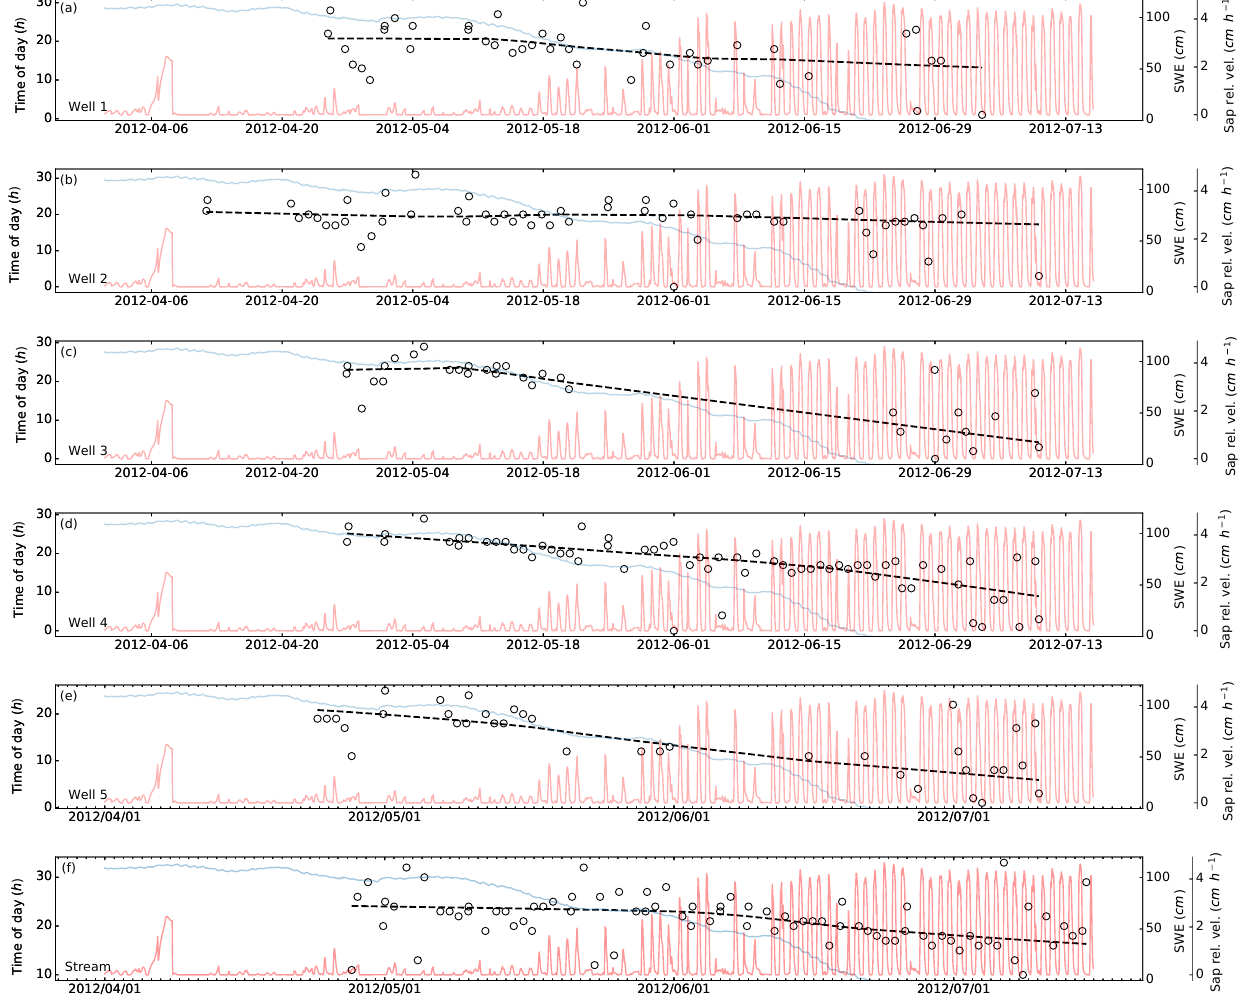
Figure 4. Black circles indicate the hour of the day when daily pressure peaks occur in wells (a–e) and the stream (f) . Ordinate time of day unwraps the hours into the following day when peaks in the evening get followed by peaks in the morning (e.g., 01:00 gets unwrapped to be hour 25 if previous days had evening peaks). The black dashed line is the lowess fit of the timing of peaks. For context, the figure background contains the SWE (blue line) and sap relative velocity (red line) as shown in Fig.